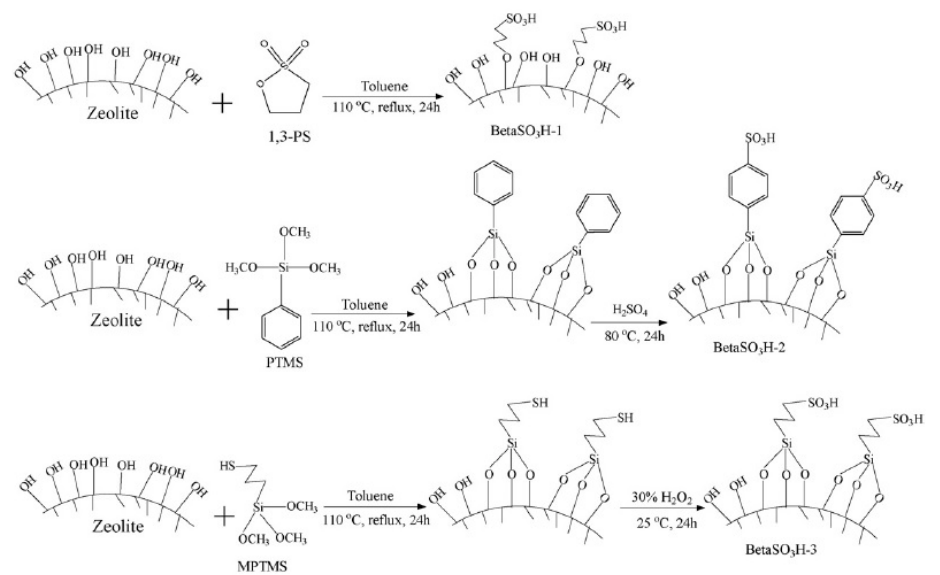
Figure 5. Schematic of three different pathways for the sulphonation of zeolite beta particles [17]. Copyright 2008, reproduced with permission from Elsevier